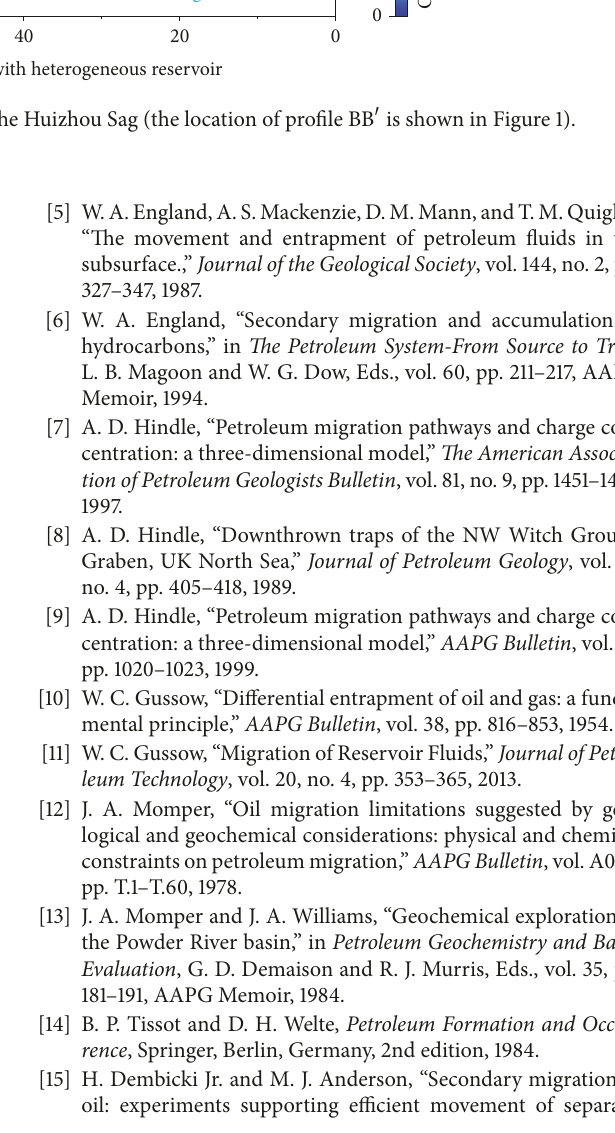
Figure 26: Sensitivity analysis of continuity of reservoir in the Huizhou Sag (the location of profile BB 󸀠 is shown in Figure 1).